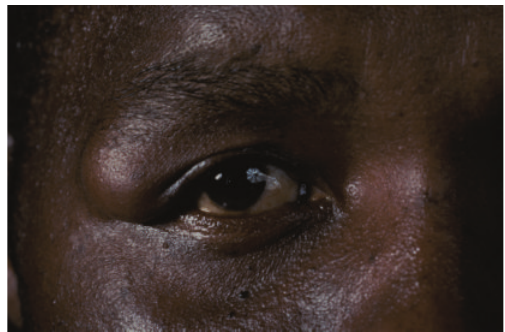
Figure 3: Partially dissected mass.